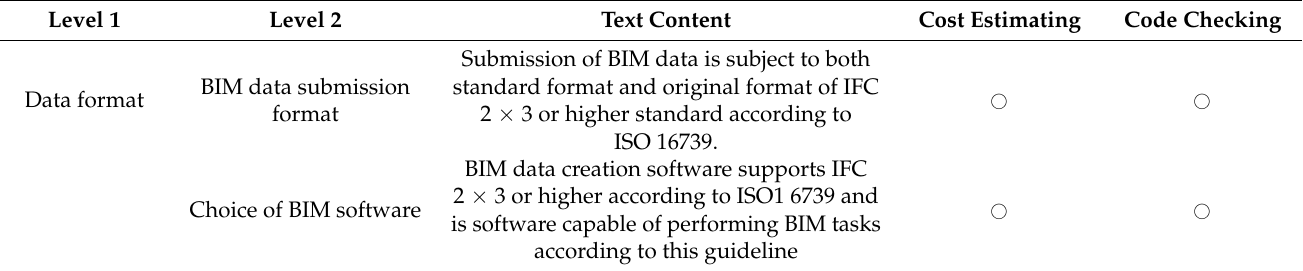
Table 10. Information Layer—Part of